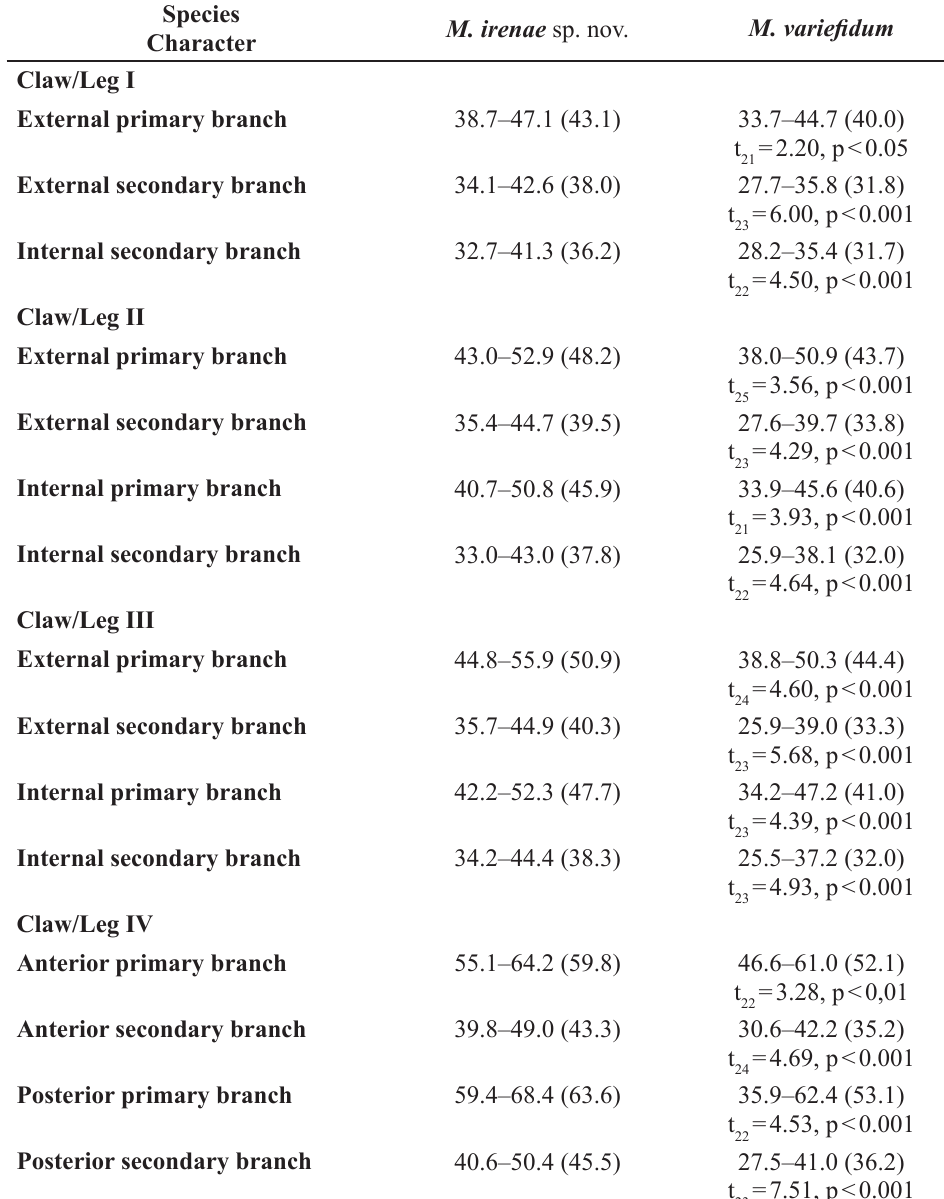
Table 7. Statistically significant differences (through one-side Student t -tests) of overlapping pt ranges of claw heights between Milnesium irenae sp. nov. and the similar